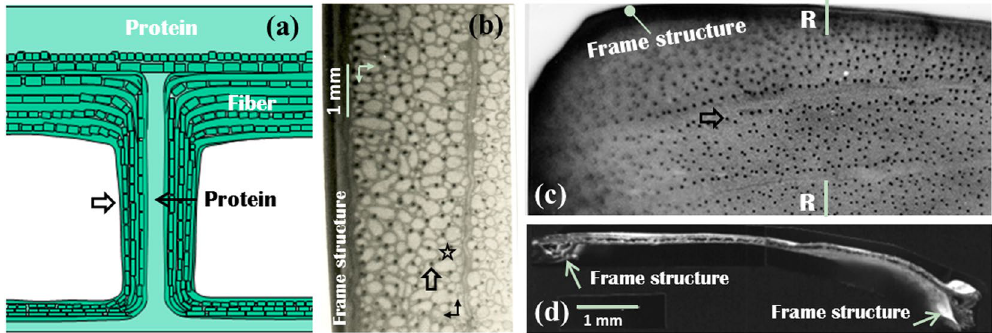
Figure 2. A simple model and the microstructure of beetle elytra. ( a ) A simple model of a trabecula 18 . ( b ) The location distribution of trabeculae in the fresh elytron of A. dichotoma 26 . ( c ) The structure of an elytron after treatment with 10% KOH 18 . ( d ) A cross-sectional view 21 of section R–R in ( c ). Trabeculae as indicated by broad